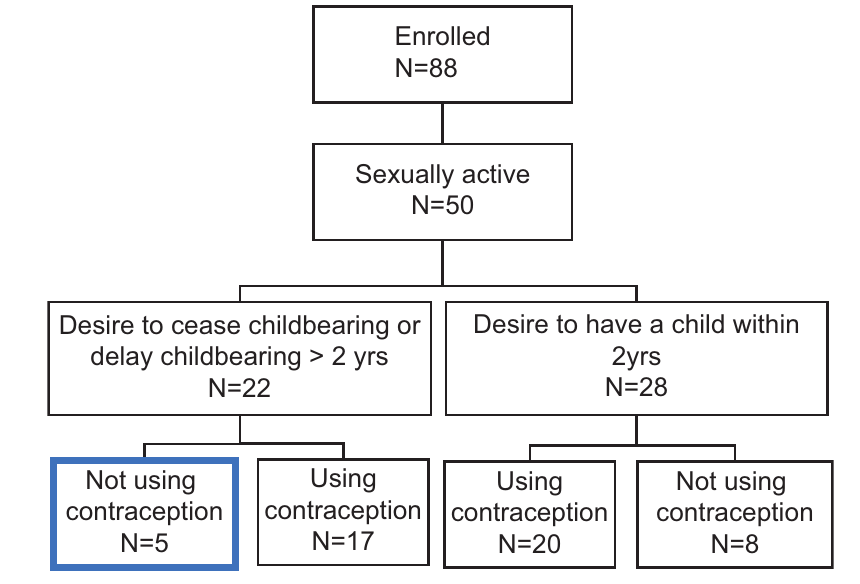
Figure 2: Unmet need for contraception Source: The estimated unmet need for contraception is calculated as the number of sexually active women of reproductive age who wish to cease childbearing or delay childbearing > 2 years but are not using a method of contraception, divided by the total number of sexually active women of reproductive age. 13